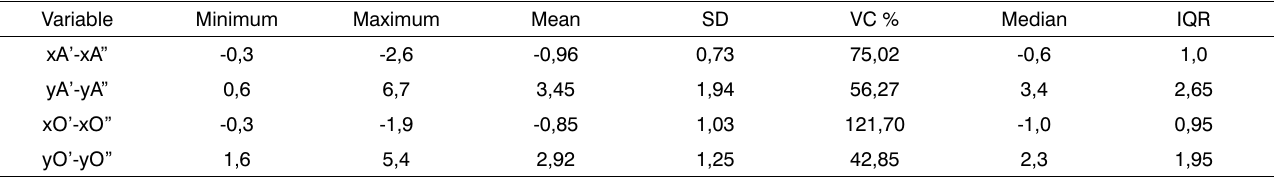
Table 3. Descriptive statistics for measurements made from point A and the orbit point in early and late postoperative tracings.